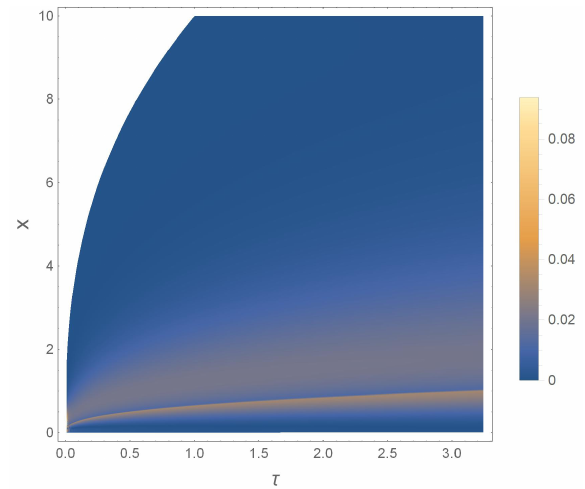
Figure 12. Absolute error for α = 0.75, λ 1 = 1, λ 2 = 2, κ 1 = 1, κ 2 = 1.